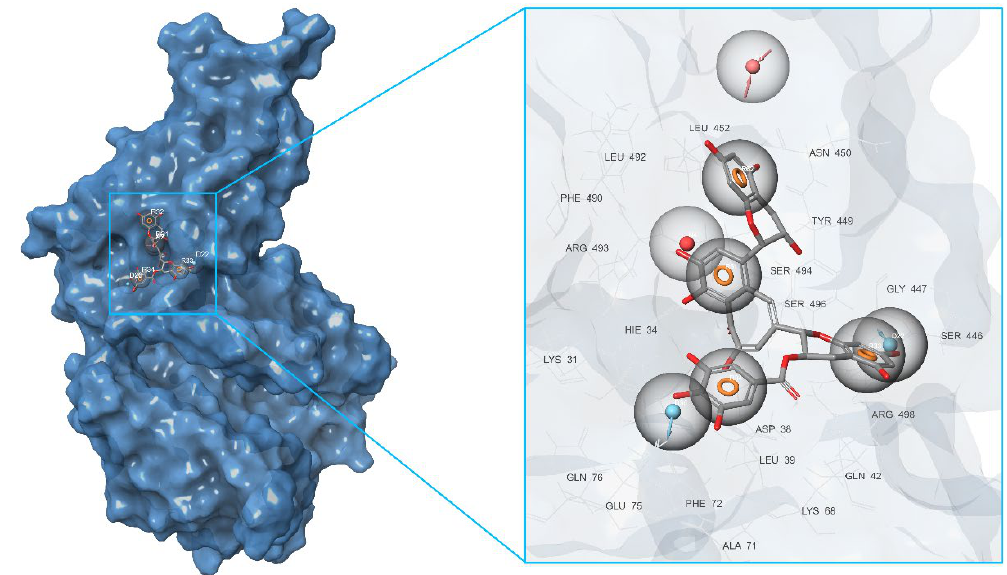
Figure 6. Pharmacophore model of the RBD site b of the spike protein generated by the Multiple ligands method.